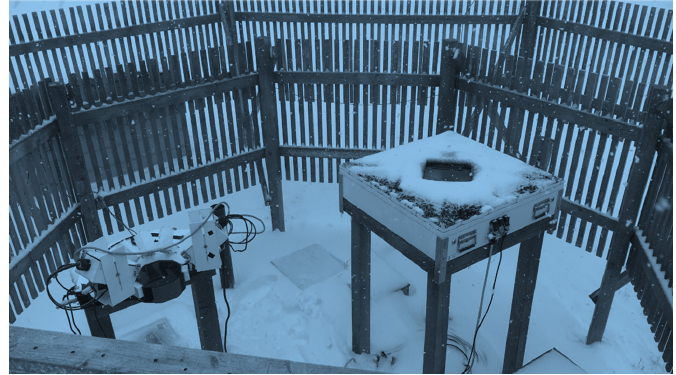
Figure 9. A 2DVD installed next to the MASC within the same wind fence at the MASCRAD instrumentation site.